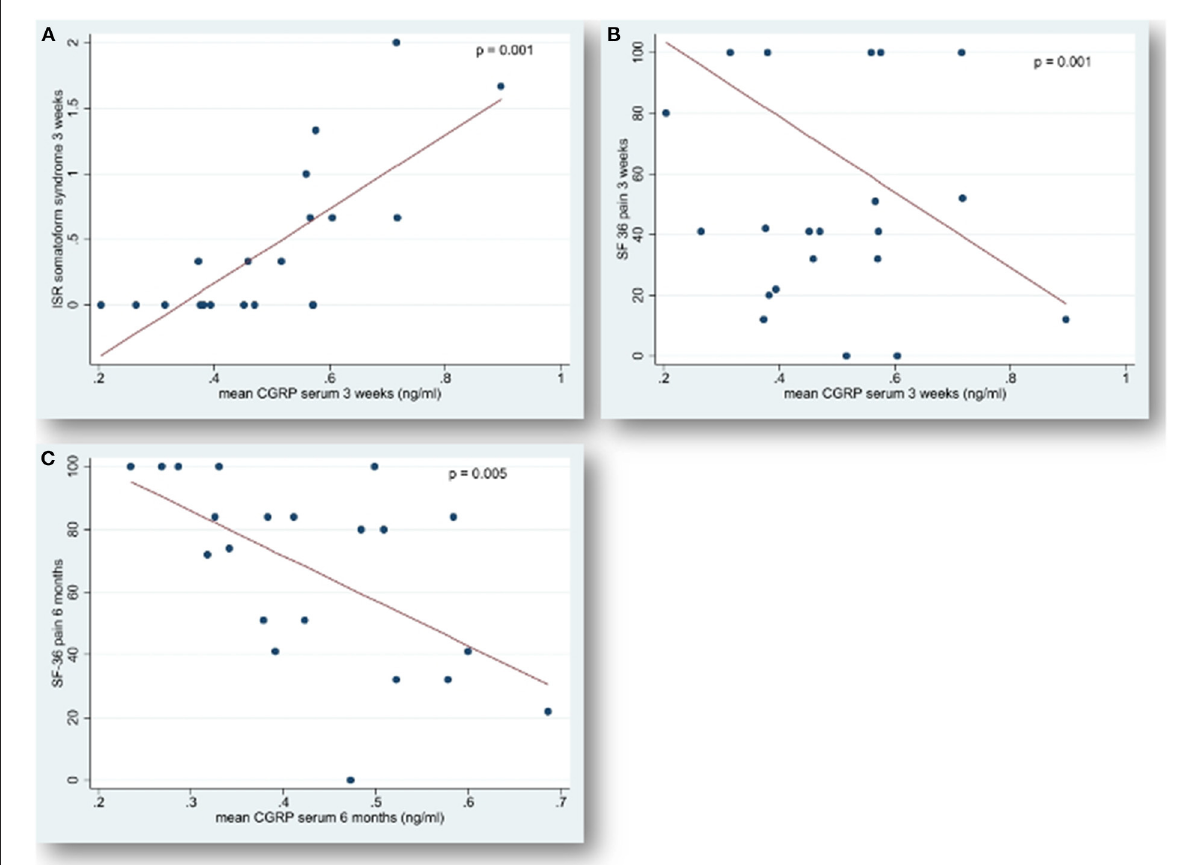
FIGURE3 Correlation of serum concentrations of CGRP with “somatoform syndrome” and “pain” after spontaneous subarachnoid hemorrhage. Endogenous calcitonin gene-related peptide (CGRP) levels in serum, measured 6 months (t 2 ) after the onset of spontaneous subarachnoid hemorrhage, plotted versus (A) somatoform syndrome 3 weeks after the hemorrhage and versus (B) pain 3 weeks and (C) pain 6 months after ictus. The ICD-10-Symptom-Rating questionnaire (ISR) (30) with 29 items and 6 syndrome scales aims at comprehensively evaluating the severity of psychological disorders. Each syndrome scale ranges from a minimum of 0 (best performance) to a maximum of 4 points with higher scores indicating a more severe symptom burden. The 36-Item Short Form Health Survey (SF-36) (31) is a 36-item generic general health questionnaire yielding scores on 8 health subscales relating to physical and psychological health. These 8 subscales can be summarized in a corresponding physical component summary and a mental component summary. Each item is scored in the range 0 to 100, and a high score defines a more favorable state of health. Items in the same scale are averaged together to create the 8 scale scores. Each dot represents the mean level of serum CGRP in [ng/ml] for each patient, indicating a significant linear correlation (compare regression line) with higher symptom burden (ISR) and with poorer neurobehavioral performance (SF-36). Statistical significance: p <